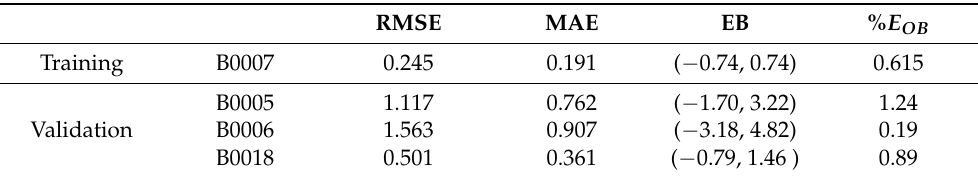
Figure 8. Extreme learning machine (ELM) model training and validation: ( a ) model trained with the B0007 dataset. ( b – d ) Model validated using the B0005, B0006, and B0018 datasets, respectively. Table 3. SOH estimation performance of deterministic ELM model for training and validation. The EB and % E OB information are also